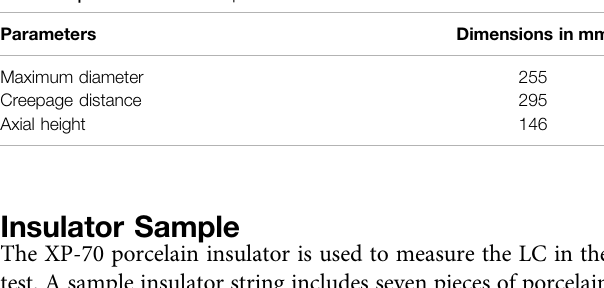
TABLE 1 | Dimensions of test porcelain